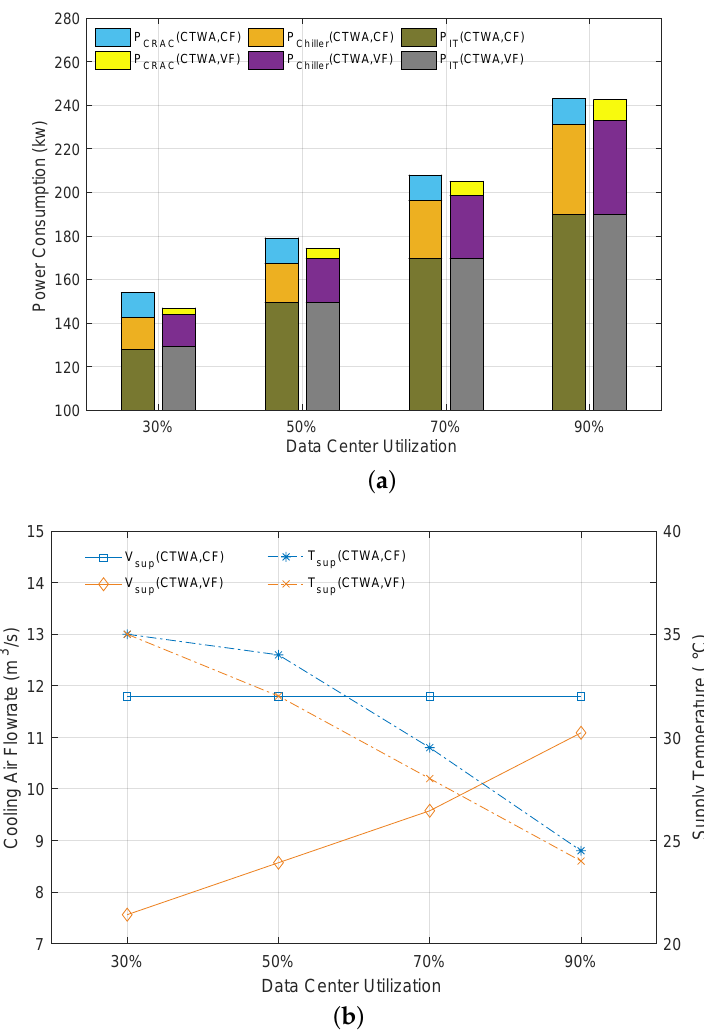
Figure 11. Power consumption and cooling parameters of data center achieved by chip temperature-aware workload allocation strategy. ( a ) Power consumption under different data center utilization. ( b ) Cooling parameters under different data center